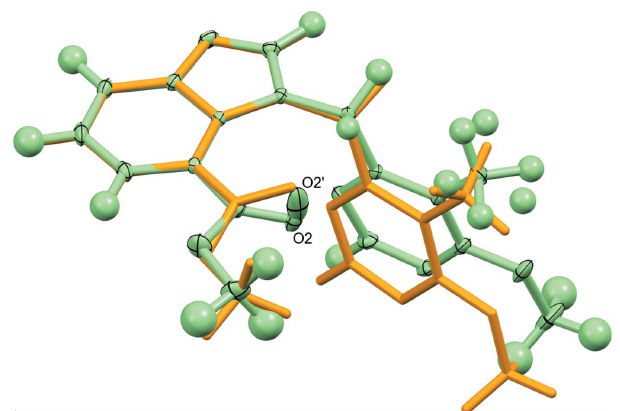
Figure 3 Structure overlay plot of the molecular structure of 3 in the crystal (green; displacement ellipsoids with 50% probability) and the DFT-optimized molecular structure (orange). The respective benzimidazole moieties were superimposed (r.m.s deviation for non-hydrogen atoms: 0.024 A˚ ).